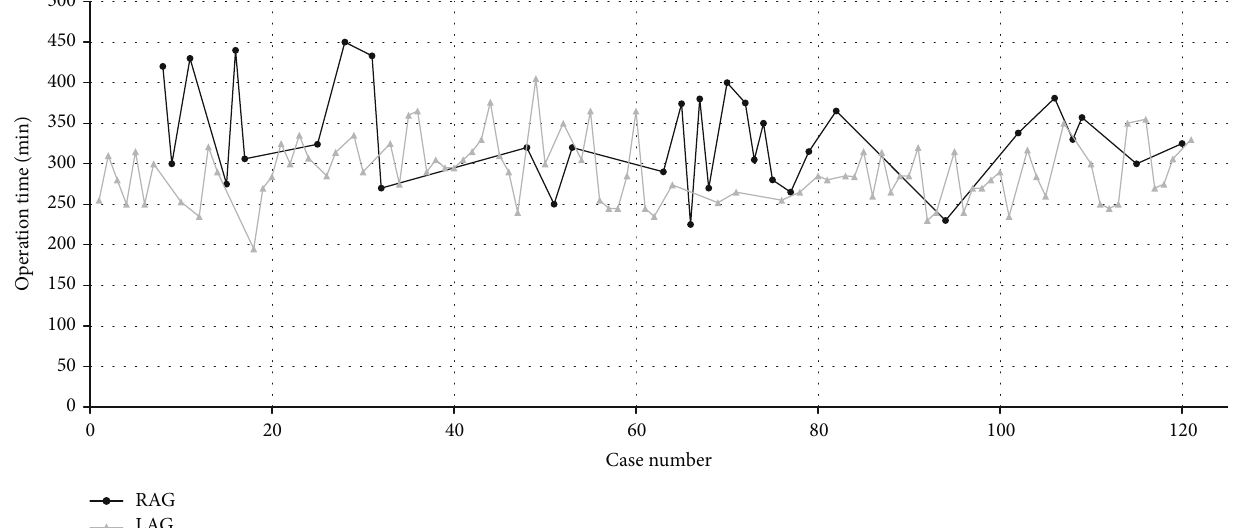
Figure 2: Operation time of RAG and LAG patients in the order of date of operation.